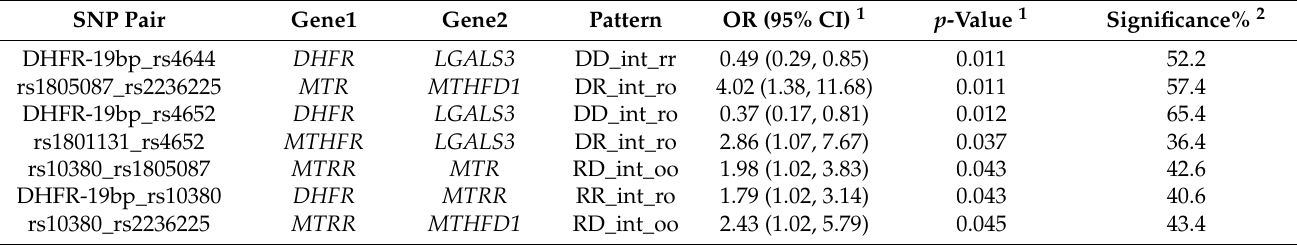
and p -interaction< p -value of any of the two composite SNPs, based on the bootstrap validation with 500 runs. Table 5. SNP–SNP interactions associated with prostate cancer aggressiveness in African Americans.